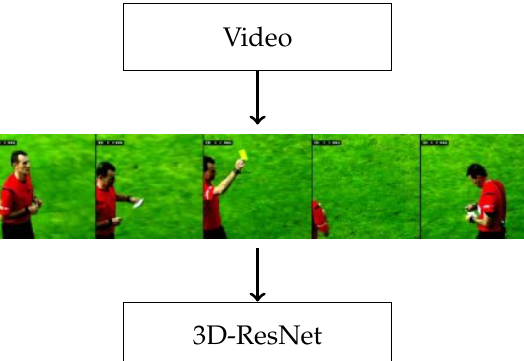
Figure 2. Illustration of the pipeline used by the video-based 3D-ResNet model.